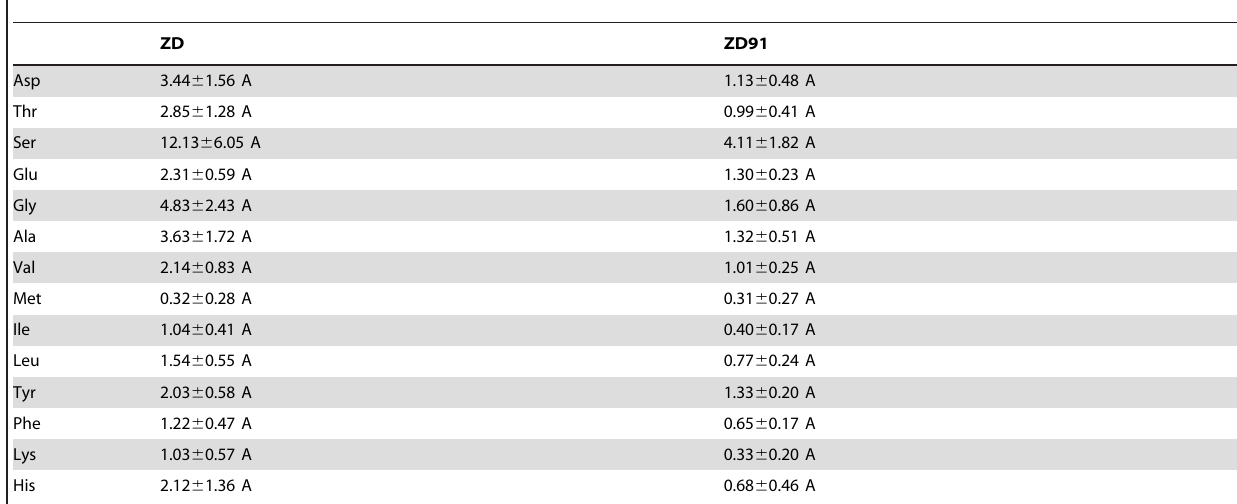
Table 2. Amino acids secreted by soybean roots in the root box at pod-setting stage ( m mol/ml) ( P ,